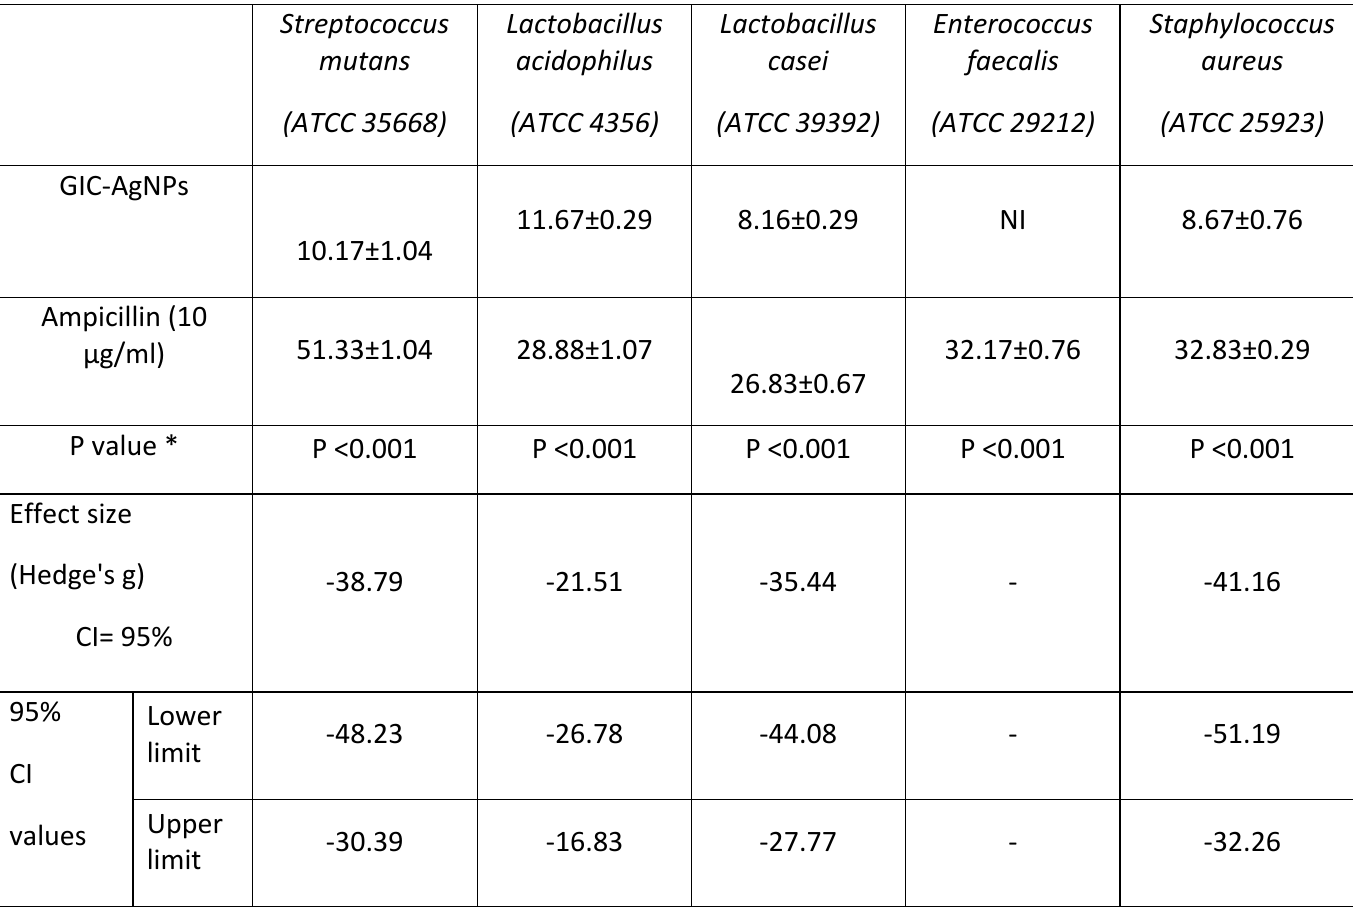
Table 2: Comparison of the inhibition zone diameter between GIC-AgNPs, and Ampicillin disks against various standard bacterial strains.